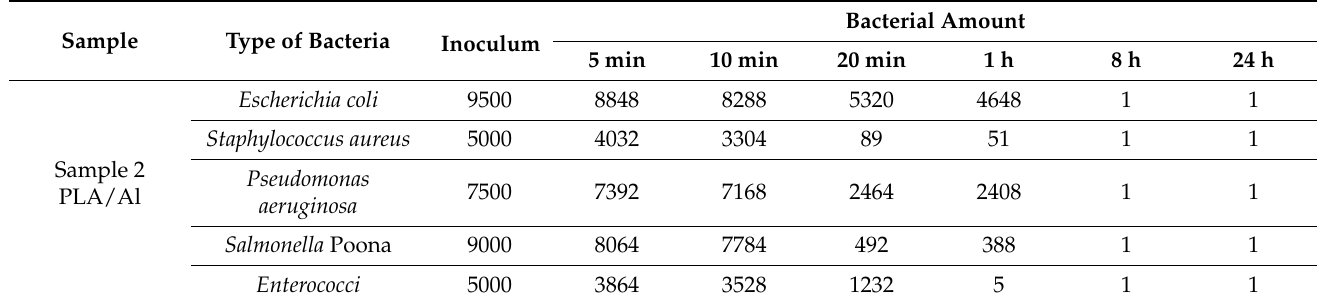
Table 3. Bacterial count on PLA/aluminum-6061 sheet over different time intervals.